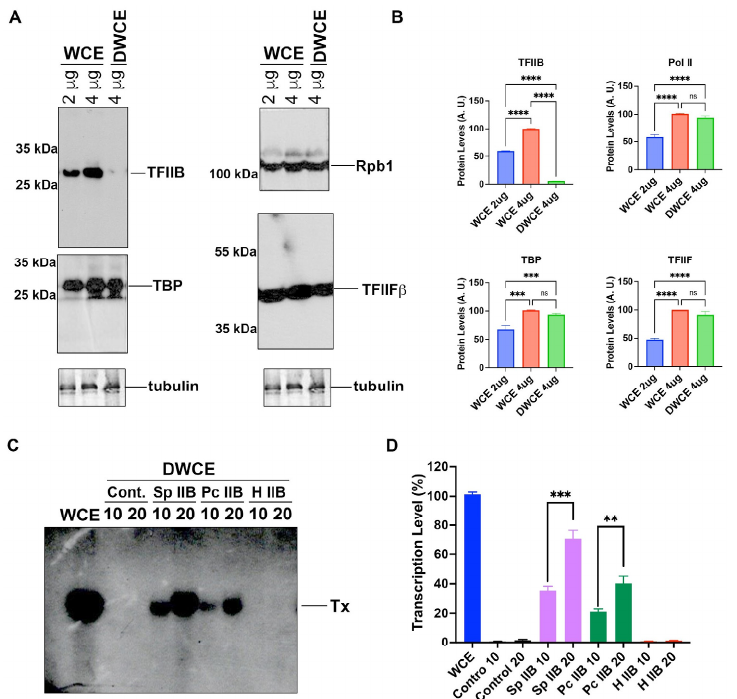
Figure 5. P. carinii TFIIB can replace in vitro the transcriptional functions of S. pombe TFIIB. ( A ) A whole cell extract was prepared from fission yeast and depleted of TFIIB by using antibody-affinity chromatography as described in Materials and Methods. A mock depleted whole cell extract (WCE) and a TFIIB-depleted whole cell extract (DWCE) were analyzed by Western blot using anti- S. pombe TFIIB antibodies cross linked to Sepharose beads. We analyzed 2 and 4 µ g of WCE and 4 µ g of DWCE. The same amounts of protein were analyzed for TBP, TFIIF β and RNAPII in separate Western blots. Tubulin analyses are indicated as internal control. ( B ) Quantification of Western blot. ns indicates non significative differences; *** indicates p < 0.001; **** indicates p < 0.0001 after Student’s t -test. ( C ) Transcription assay and recovery of the transcriptional activity by different TFIIBs. The DWCE was supplemented with 10, 20 ng of heat-inactivated S. pombe TFIIB (control) and with 10, 20 ng of active S. pombe TFIIB (Sp IIB). The DWCE was supplemented with 10, 20 ng of active P. carinii TFIIB (Pc IIB). Human TFIIB (H IIB) was also used to supplement the DWCE (10 and 20 ng). ( D ) Quantification of Figure 5C. ** indicates p < 0.005 and *** indicates p < 0.001 after Student’s t